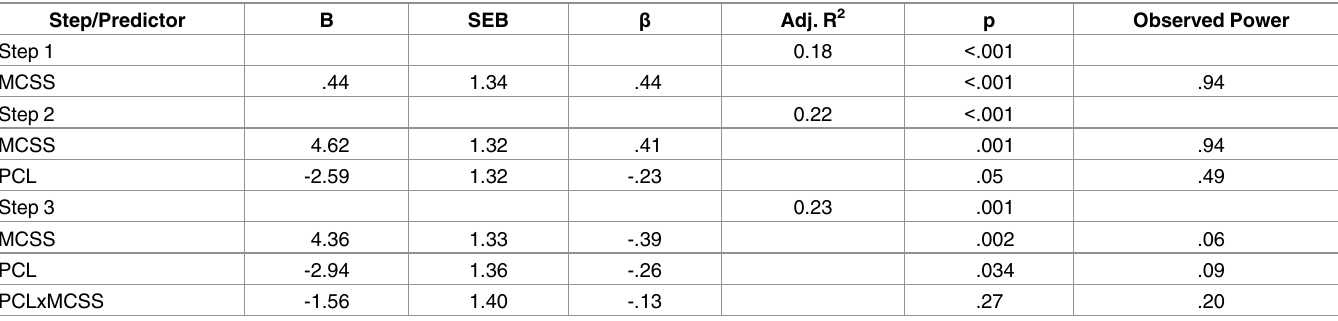
Table 2. Multiple regression analysesfor hypotheses 1–3: Criterion variable for all analysesis Job in General (job satisfaction).